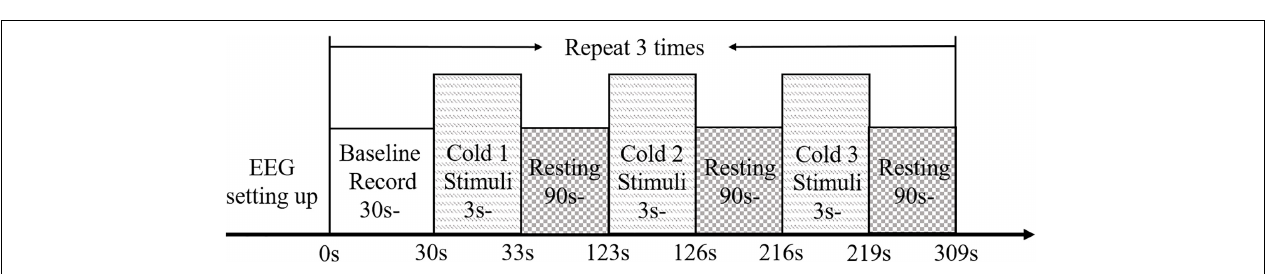
FIGURE 2 | The experimental protocol for EEG evaluation presented with the